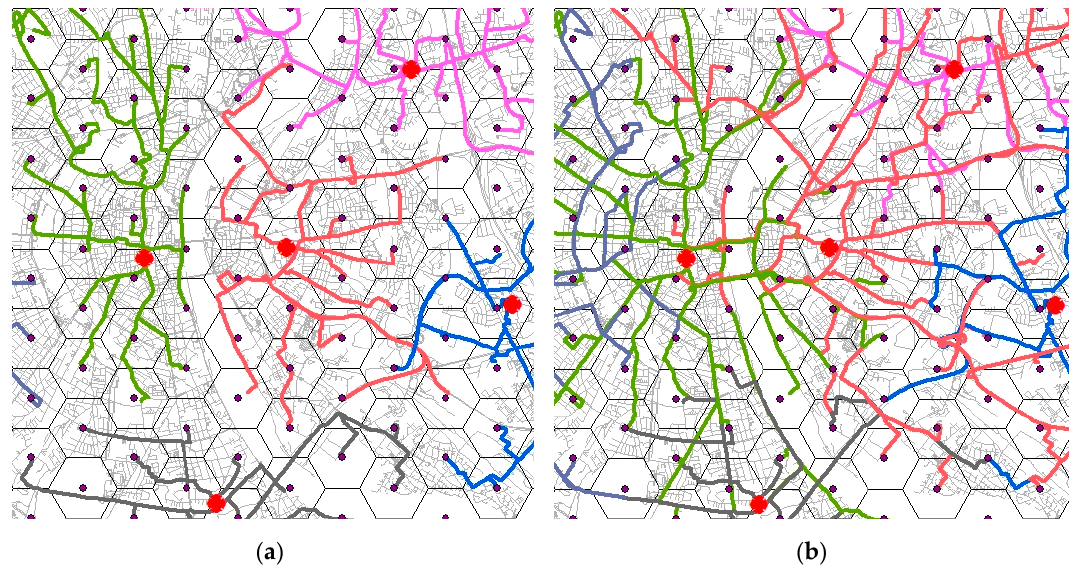
Figure 3. ( a ): Closest Facility calculation with one facility per tile. ( b ): Same setting with two facilities per tile. (Legend: Red = Facilities; Grey = Road network; Colour = Calculated routes).